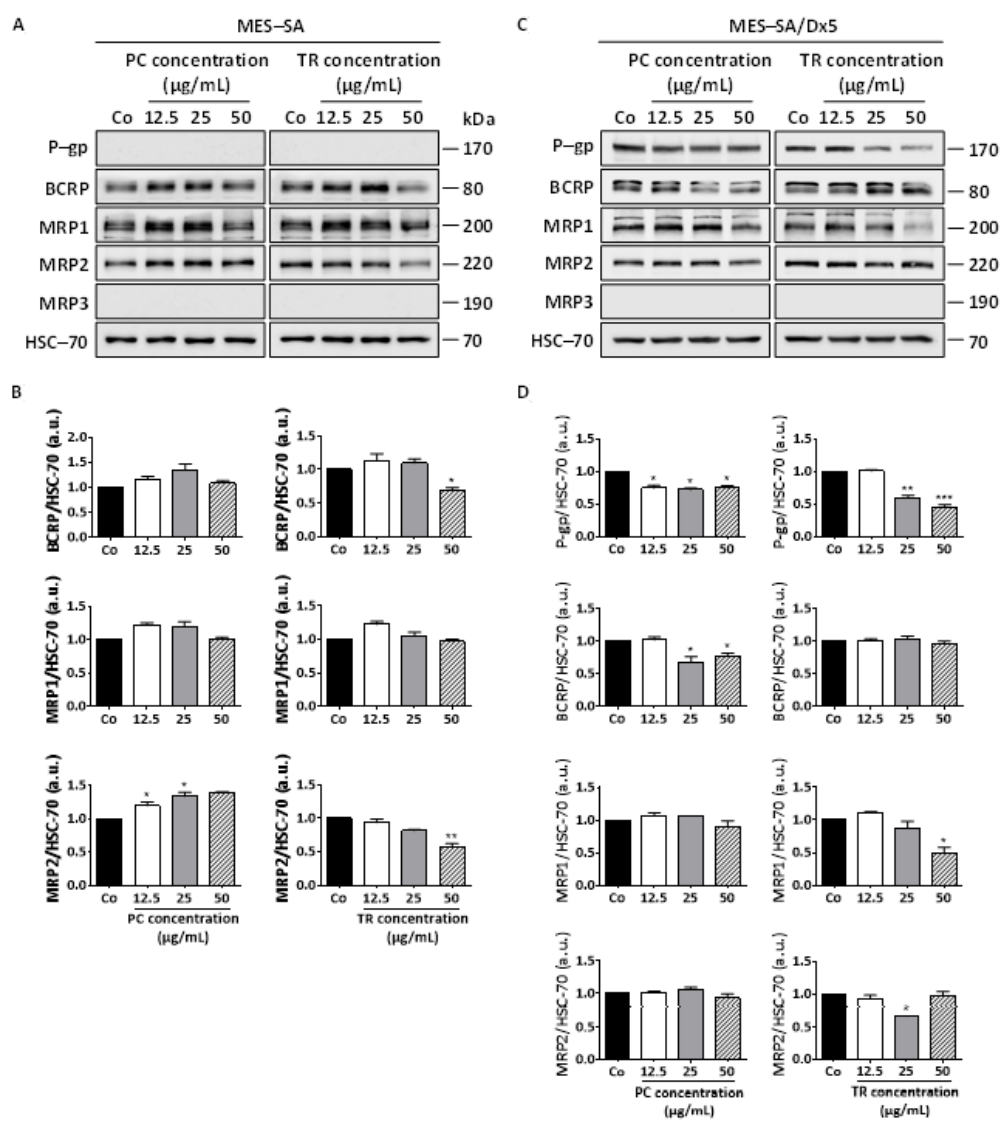
Figure 10. Differential expression of ABC transporters in MES-SA and MES-SA/Dx5 to Pituranthos chloranthus (PC) and Teucrium ramosissimum Desf. (TR) extracts. ( A ) Immunoblot analysis of P-glycoprotein (P-gp), breast cancer resistance protein (BCRP), and multidrug resistance proteins (MRP1, MRP2, and MRP3) after a 72 h treatment with vehicle (dimethyl sulfoxide, DMSO; Control, Co) or indicated concentrations of PC and TR in MES-SA cells. Heat shock cognate 70 (HSC-70) was used as the loading control. A representative blot from three independent experiments is shown. ( B ) Densitometric quantification of Western blotting obtained in (A). Data are expressed as mean fold induction ± Standard Error of the Mean (SEM) of three independent experiments; p -values were determined by a one-way ANOVA followed by Tukey’s multiple comparison test. * p < 0.05, ** p < 0.01, and *** p < 0.001 compared to control (Co) condition. F values of ANOVA tests (significant results): MRP2 expression, F = 15.53 and F = 28.46 for PC and TR, respectively; BCRP expression, F = 10.18 for TR. ( C ) Immunoblot analysis of P-gp, BCRP, MRP1, MRP2, and MRP3 after a 72 h treatment with vehicle (dimethyl sulfoxide, DMSO; Control, Co) or indicated concentrations of PC and TR in MES-SA/Dx5 cells. HSC-70 was used as the loading control. A representative blot from three independent experiments is shown. ( D ) Densitometric quantification of Western blotting obtained in ( C ). Data are expressed as mean fold induction ± Standard Error of the Mean (SEM) of three independent experiments; p -values were determined by a one-way ANOVA followed by Tukey’s multiple comparison test. * p < 0.05, ** p < 0.01, and *** p < 0.001 compared to control (Co) condition. F values of ANOVA tests (significant results): P-gp expression, F = 18.25 and 89.22 for PC and TR, respectively; BCRP expression, F = 9.96 for PC; MRP1 expression, F = 15.32 for TR; MRP2 expression, F = 16.57 for